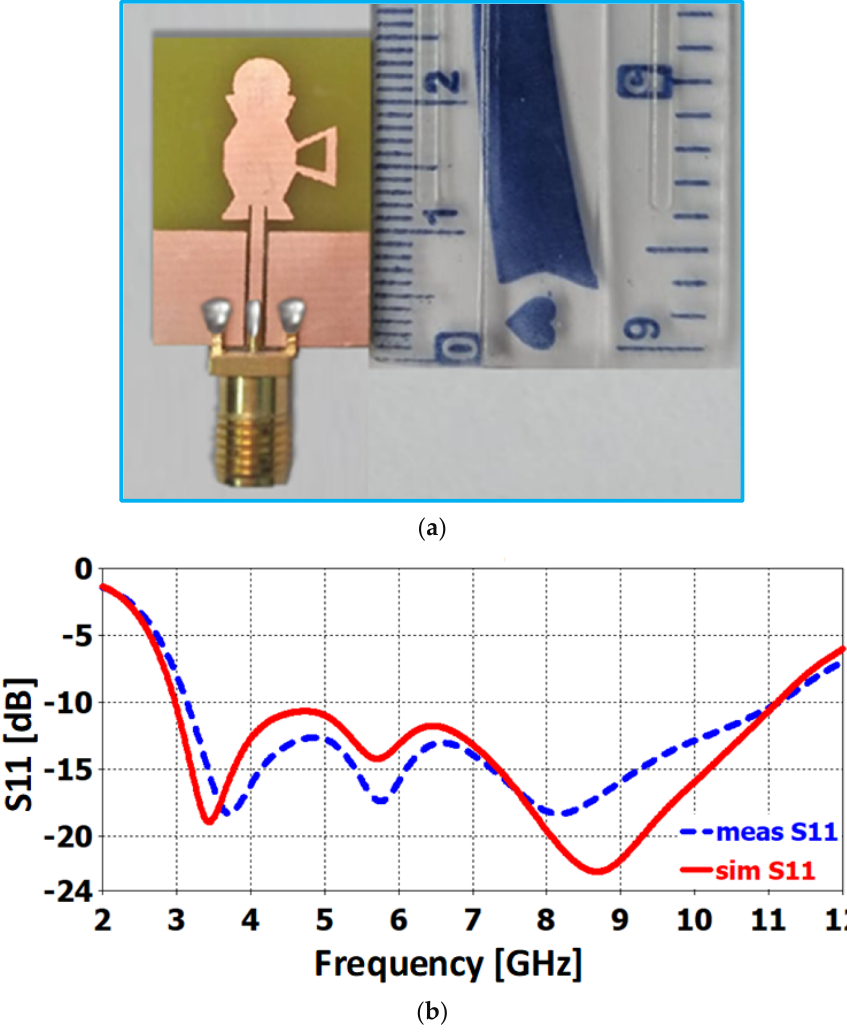
Figure 7. ( a ) Printed UWB prototype; ( b ) comparison of simulated and measured reflection coefficients (S 11 ).